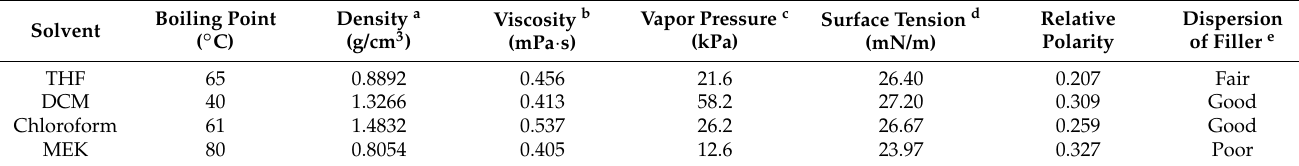
Table 2. Physical properties of solvents used in this study